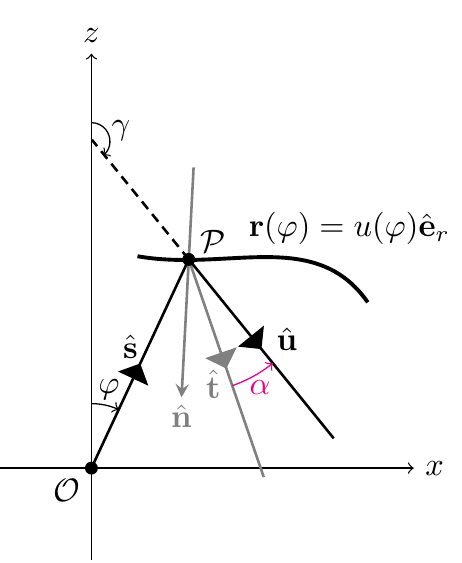
Figure 3. Cross-section of a di ff use rotationally symmetric re- flector along the plane of